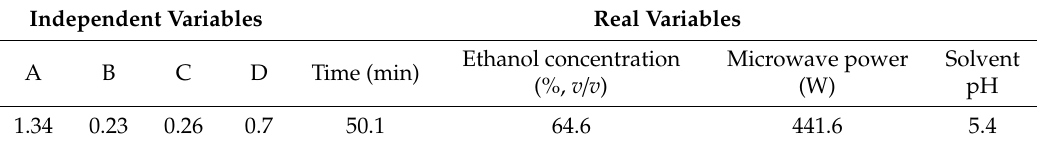
Table 5. The values of the independent variable and real variables.